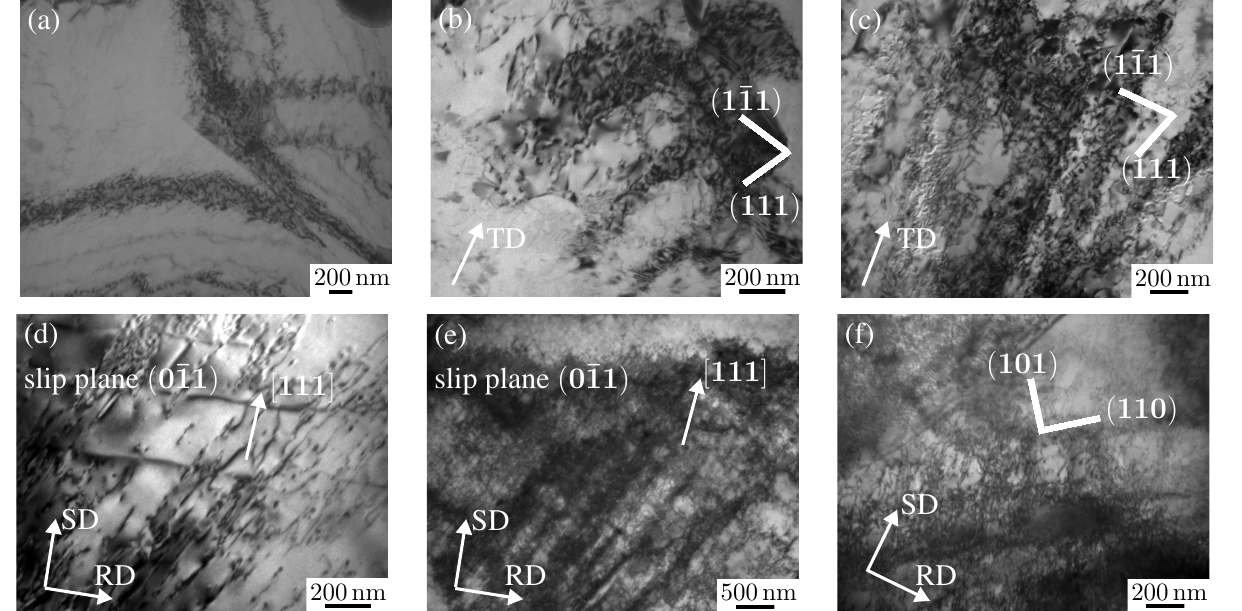
Figure 3. TEM images of dislocation structures of AA6016: ( a ) as-received material; after plane strain tension up to 10% ( b ) and up to 20% ( c ) for tension in the RD; after 10% ( d ), 20% ( e ) and 30% ( f ) simple shear loading, where the SD is orthogonal to the